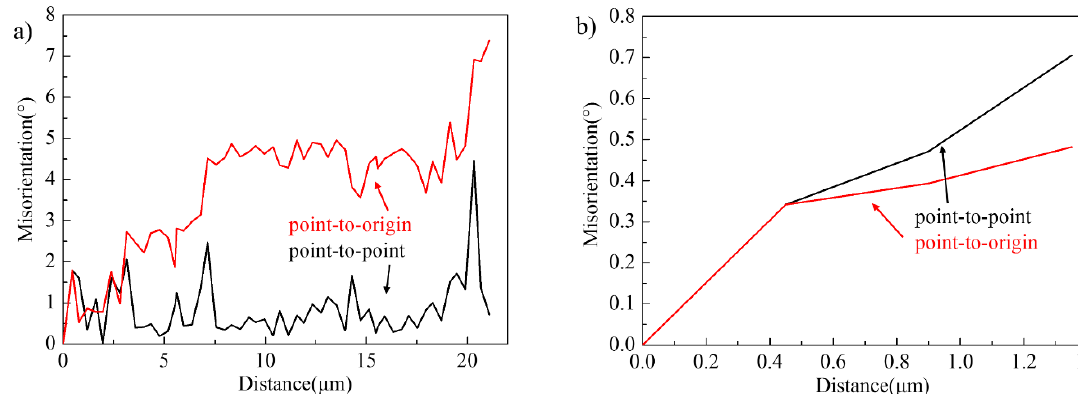
7 of 15 Figure 5. Misorientation measured along ( a ) L1 line and ( b ) H1 line in Figure 4b. In addition to parts of α grains formed by the CDRX of α lamellae, more α grains were formed by the CDRX of α grains distributed around lamellar colonies during defor- mation. The CDRX of parent α grains occurred around lamellar colonies, and the original coarse α grains transformed into finer α grains after three passes of hot-packed rolling, as